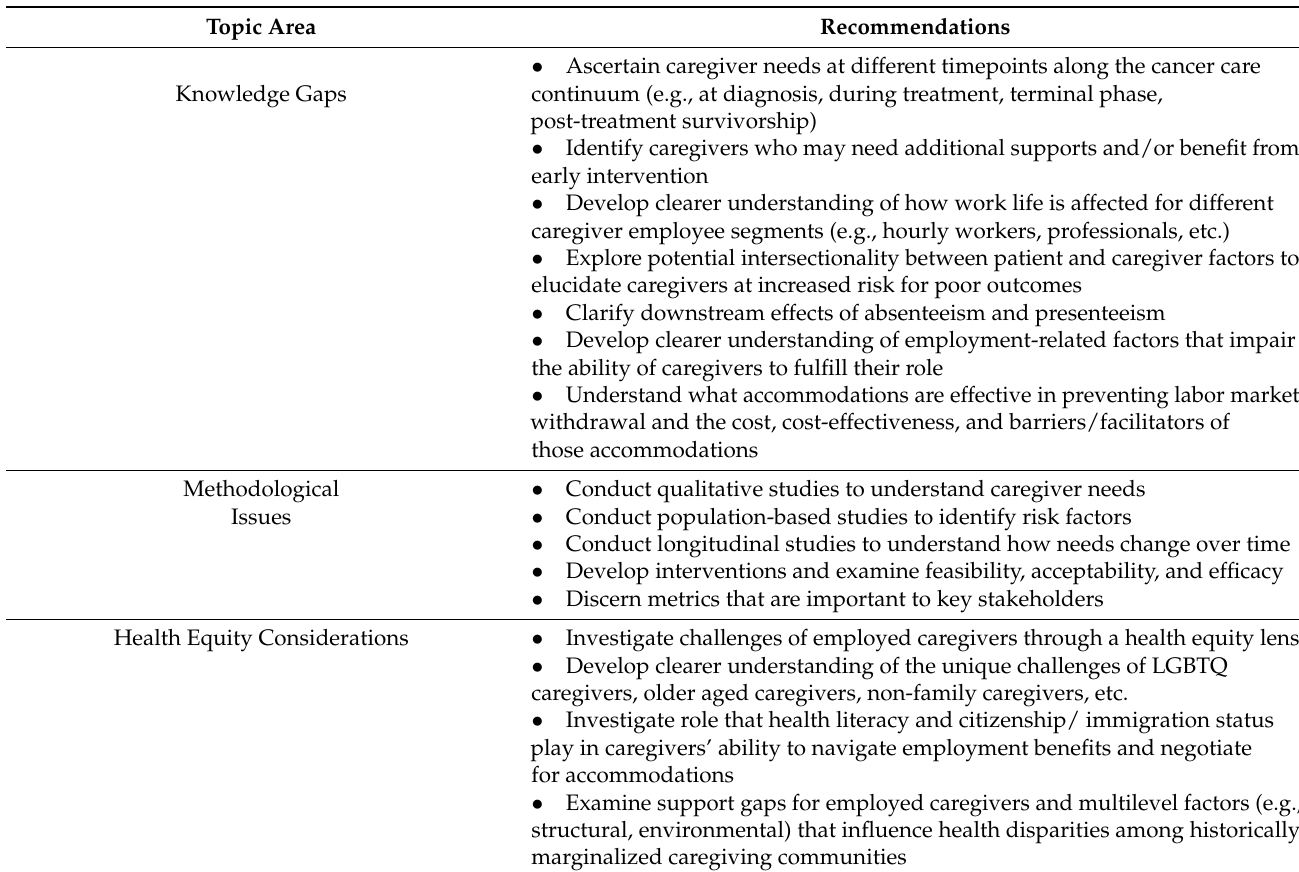
Table 1. Research